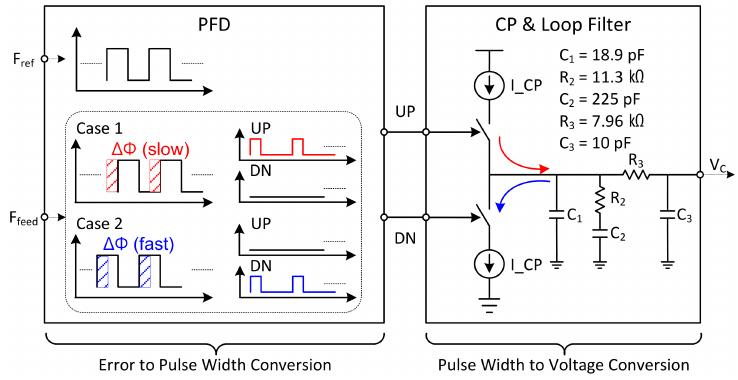
Figure 10. The conceptual block diagram on how to operate the error correction part.